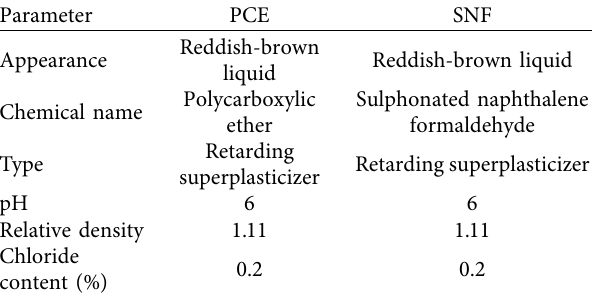
Table 8: Properties of the chemical